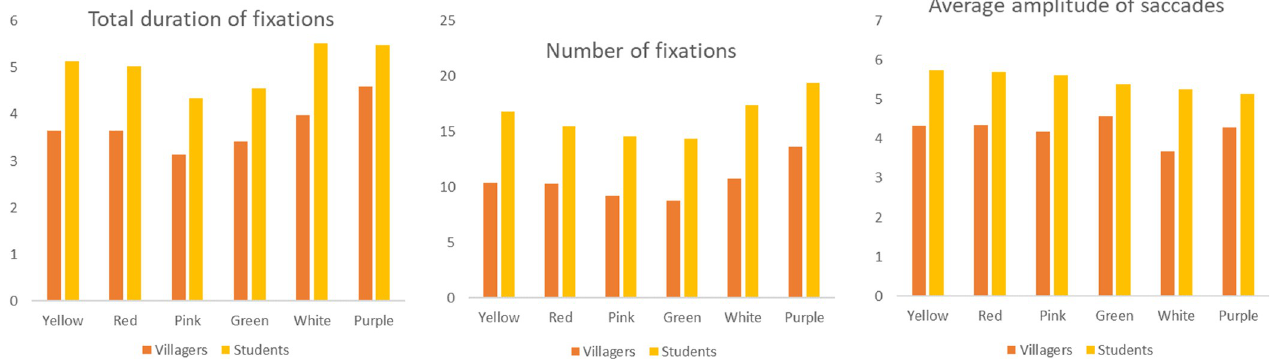
Fig 7. The average value of eye movement indicators of villagers and students for different